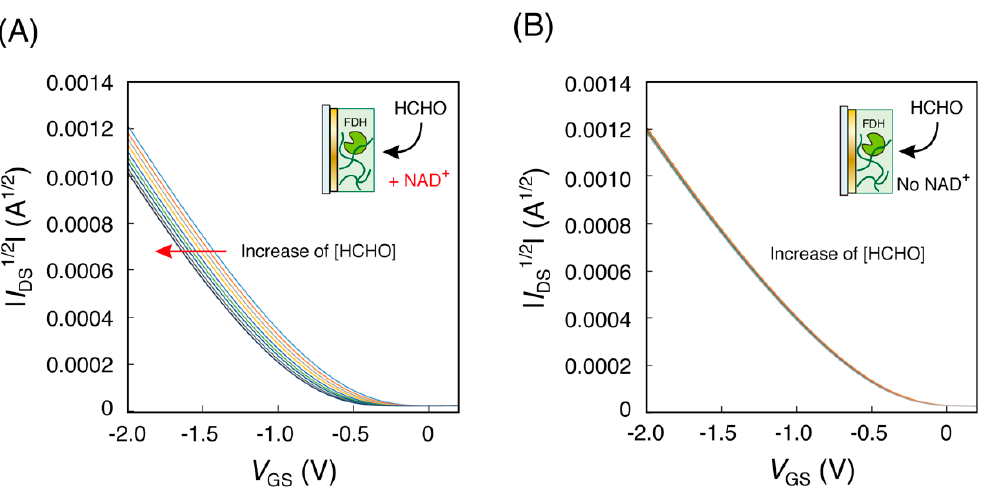
Figure 2. Transfer characteristic curves of the OFET-based sensor with a gold electrode coating FDH/chitosan (CT) gel, responding to the addition of formaldehyde solution at different concentrations (0–2.6 mM) ( A ) in the presence of and ( B ) in the absence of NAD + . Experimental condition: 1 or 0 mM of [NAD + ] in 10 mM phosphate buffer (pH 7.4) at 25 °C.